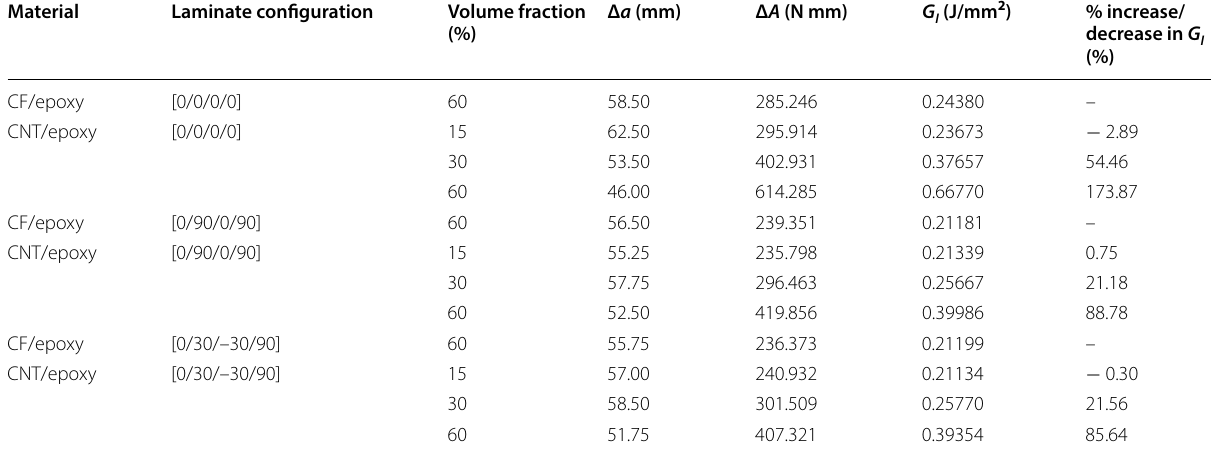
Table 4 Percentage increase/decrease in mode I fracture energy of the CNT/epoxy with volume fraction compared to CF/ epoxy composite at a constant CF volume fraction of 60% Material Laminate